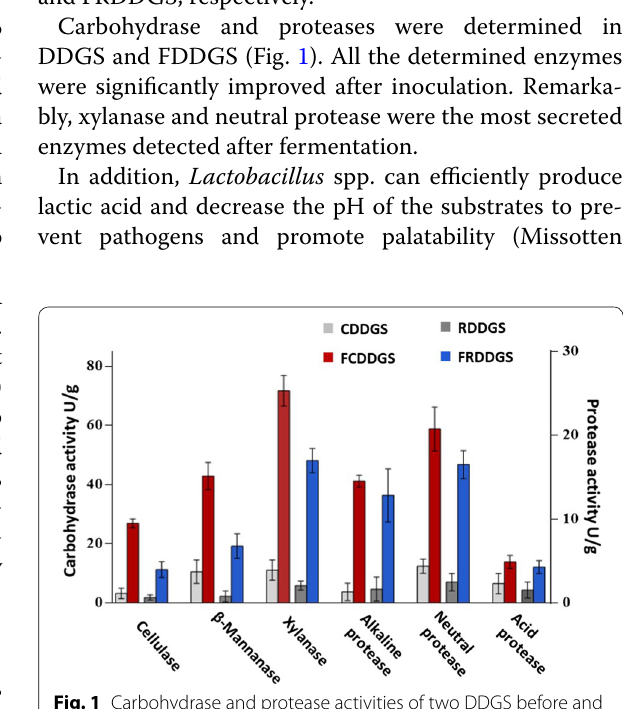
Table 2 Microbial metabolites of two DDGS before and after fermentation (as-fed basis) Item, % CDDGS RDDGS